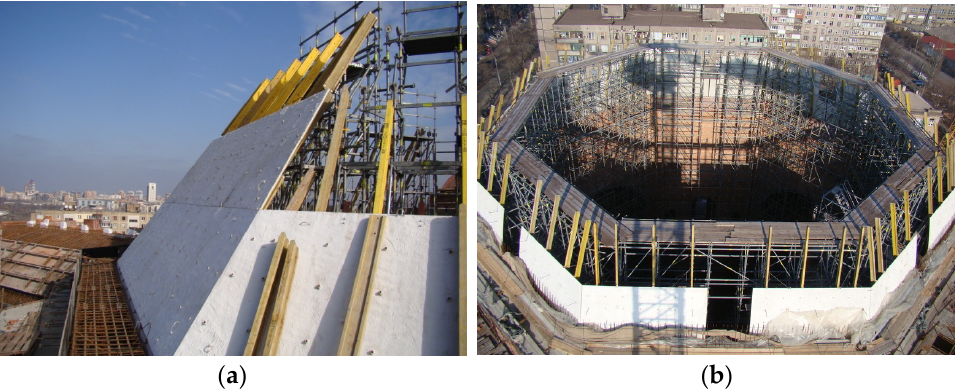
Figure 34. GFRC permanent formwork: ( a ) Church in Donetsk, Ukraine [137]; ( b ) Church in Mariupol, Ukraine [138].